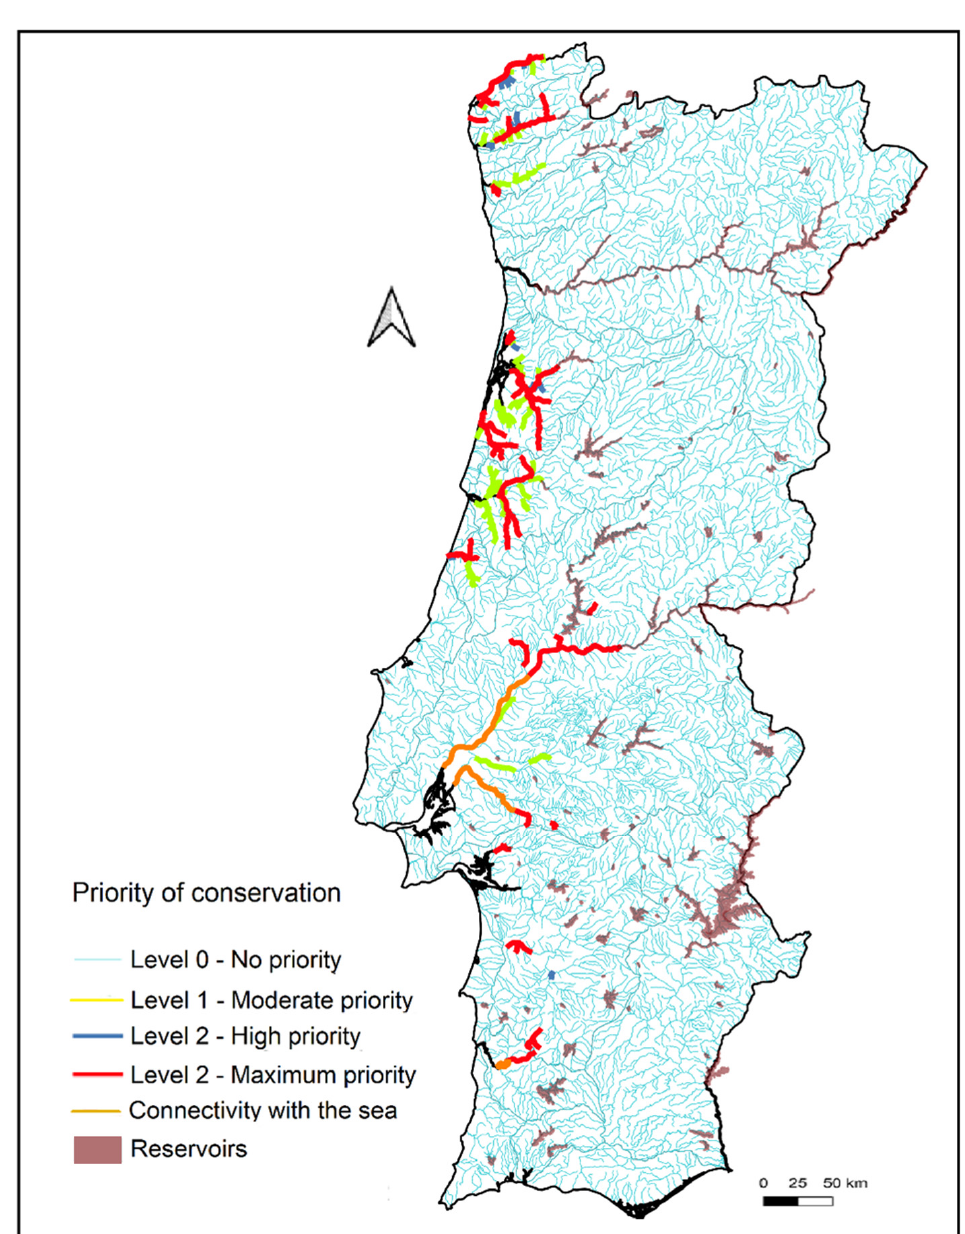
Figure 4. Map of conservation priority for G. aculeatus in mainland Portugal following the criteria defined in Section 2 (Section 2.5). For the identification of the main river basins see Figure